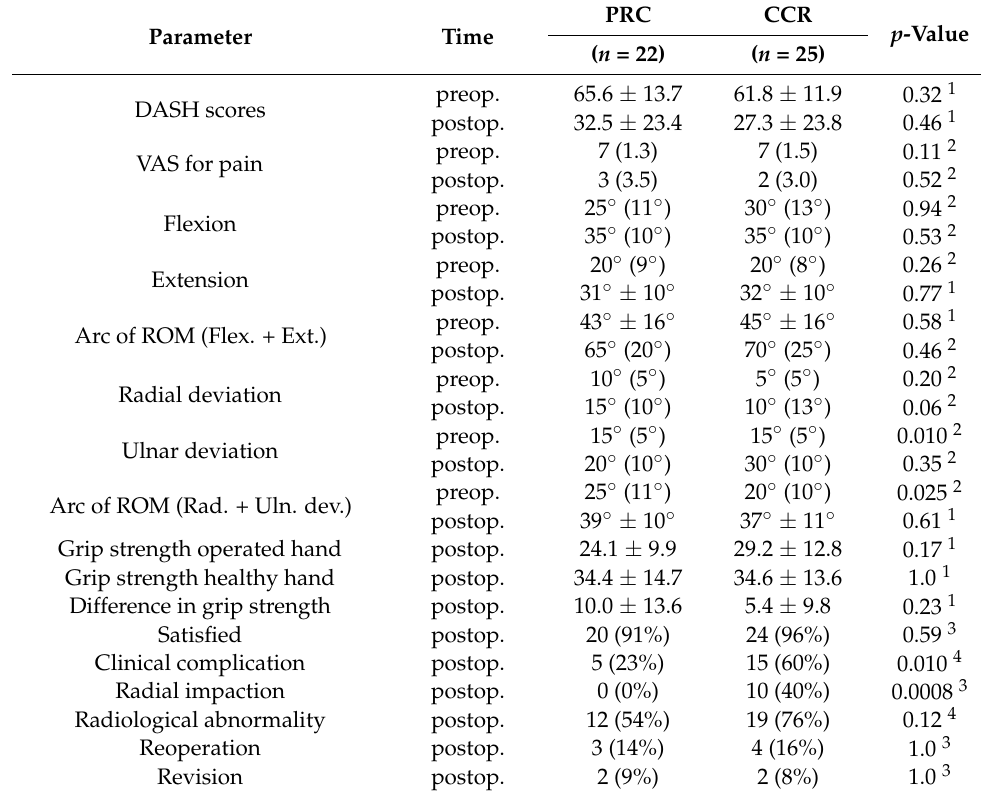
Table 3. Outcome